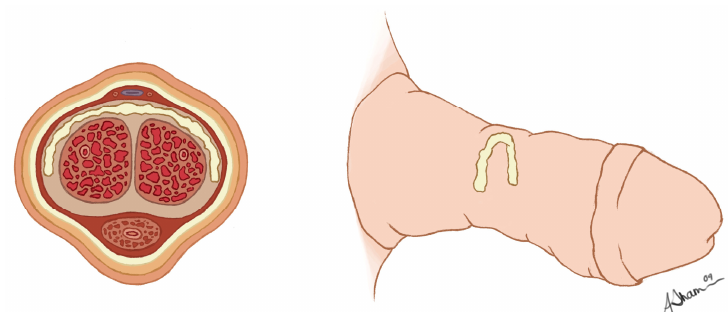
FIGURE 2. Circumferential scar causing bottlenecking/hourglass